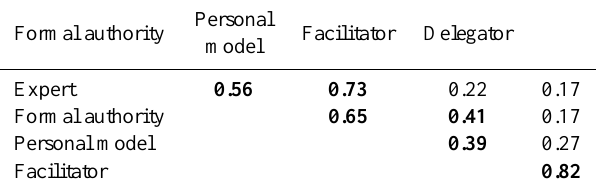
Table A3. Correlations among teaching styles (Survey 1) for UTQ